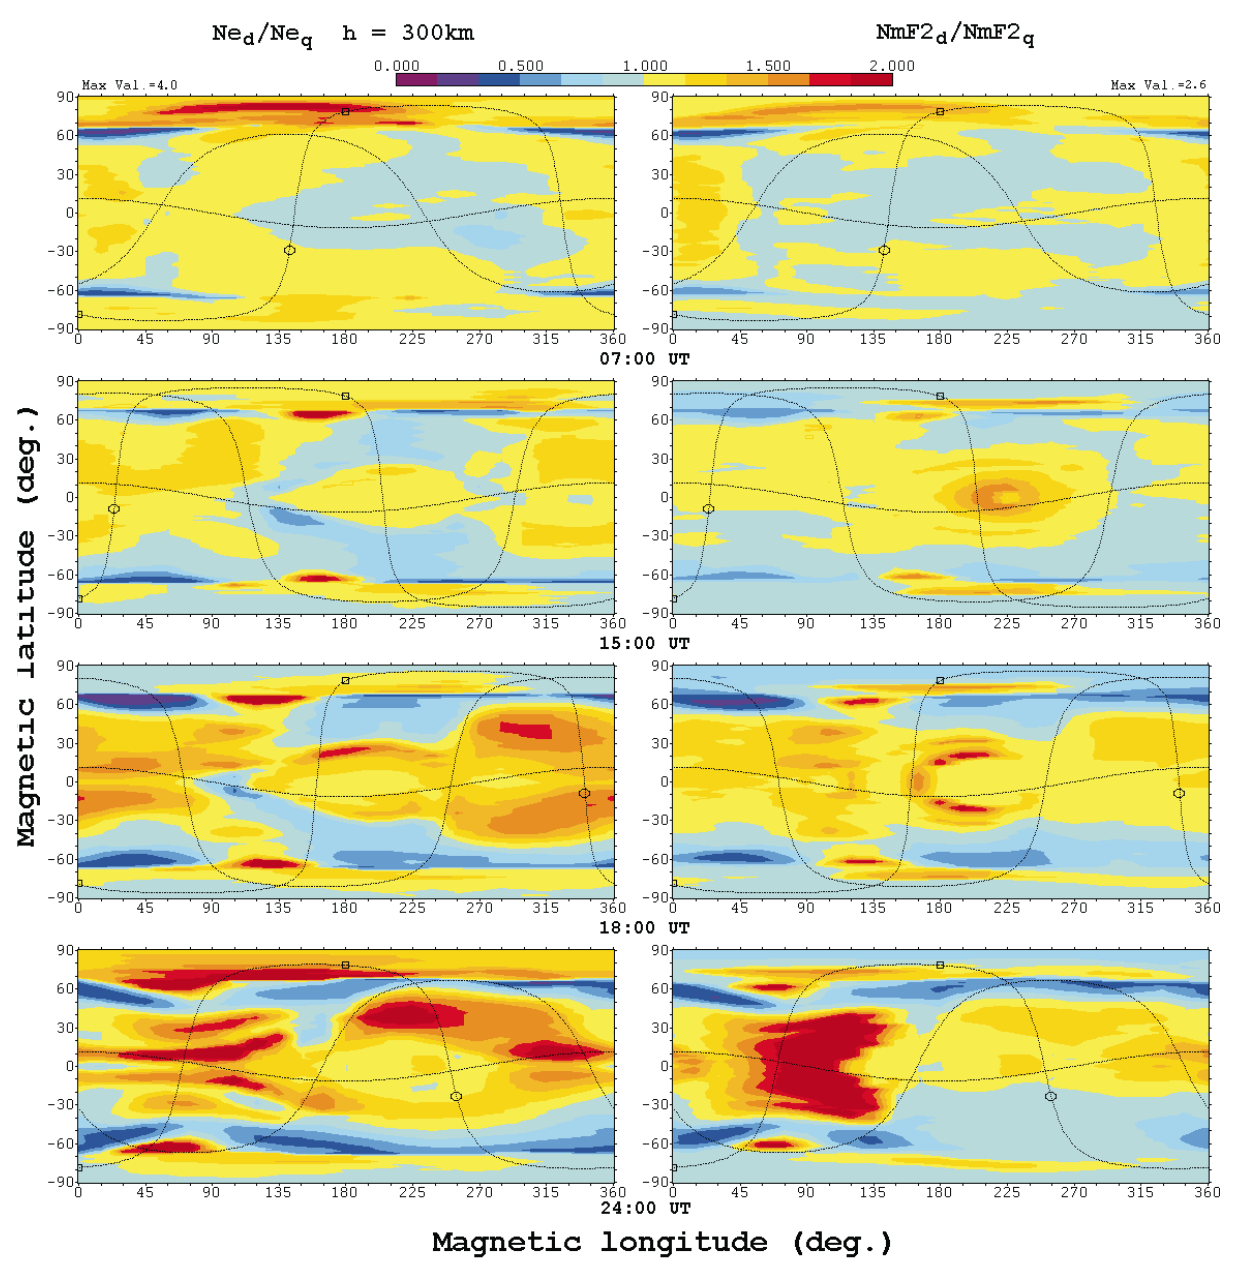
Fig. 5. The electron concentration disturbance patterns (storm to quiet concentration ratio) for the same moments of UT as in Figs. 2, 3 and 4. On the left they are shown with respect to the same fixed height of 300 km as in the previous figures while the right side panels show